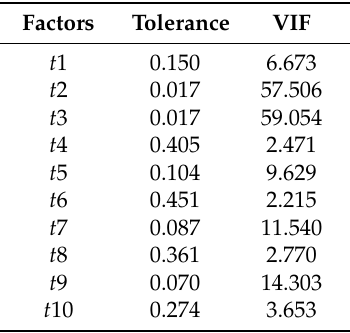
Figure 10. Variable importance in projection (VIP) of the environmental factors for CO 2 exchange. t 1 is the WTL, t 2 is soil temperature; t 3 is air temperature; t 4 is the salt content; t 5 is relative humidity; t 6 is precipitation; t 7 is biomass; t 8 is sunshine duration; t 9 is height; and t 10 is wind speed. The environmental factors attributed to CO 2 exchange were studied using the PLS method.